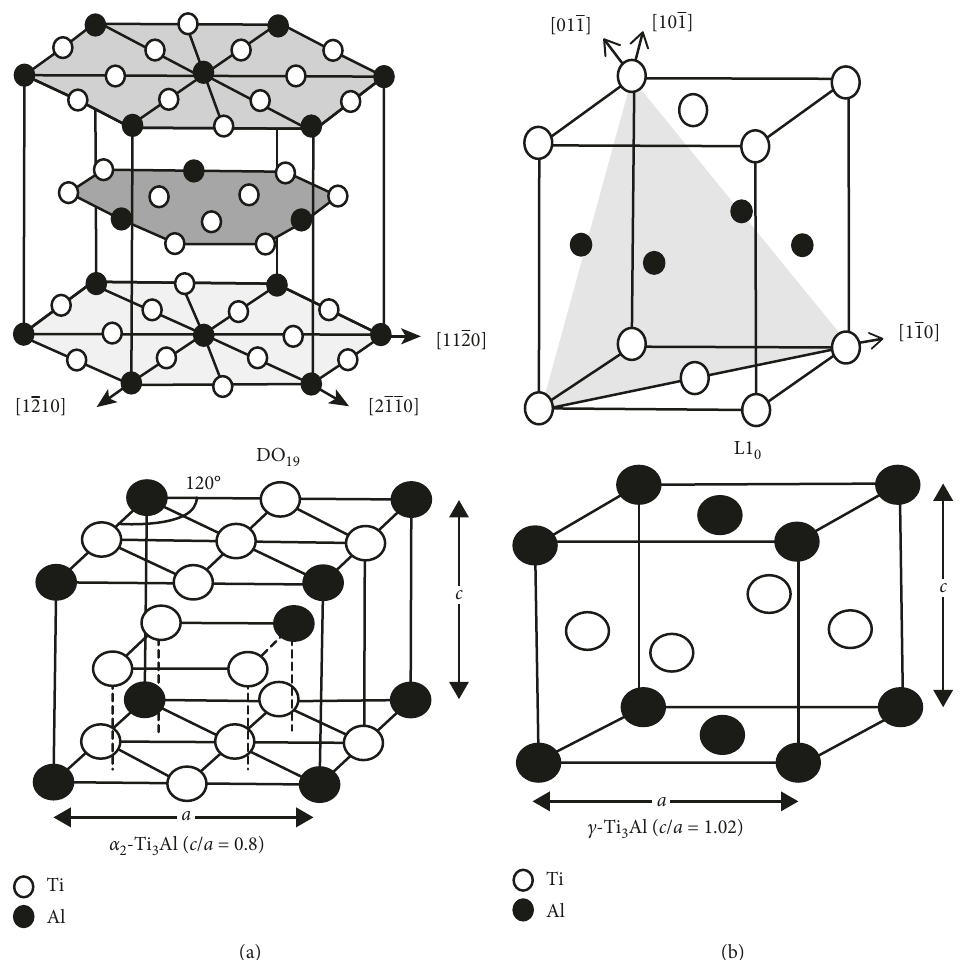
Figure 4: (a) Hexagonal crystal structure (DO